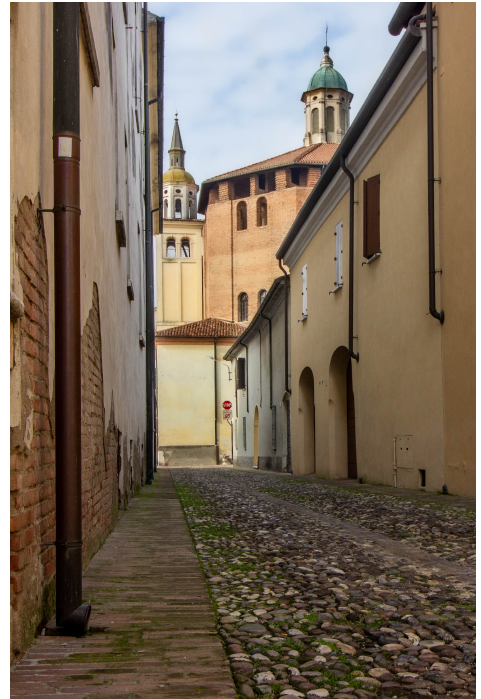
Figure 2. A street in Sabbioneta, site for the development of this research empirical investigation. The picture shows some features of the historical city that doesn’t meet the minimum standard of accessibility, e.g. undersized pedestrian sidewalks and quality of the road material that prevent a safe crossing of the same.